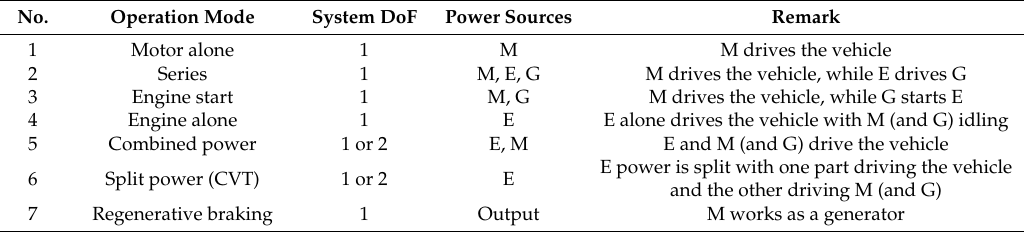
Table 1. Proposed operation modes of a new series-parallel hybrid system.